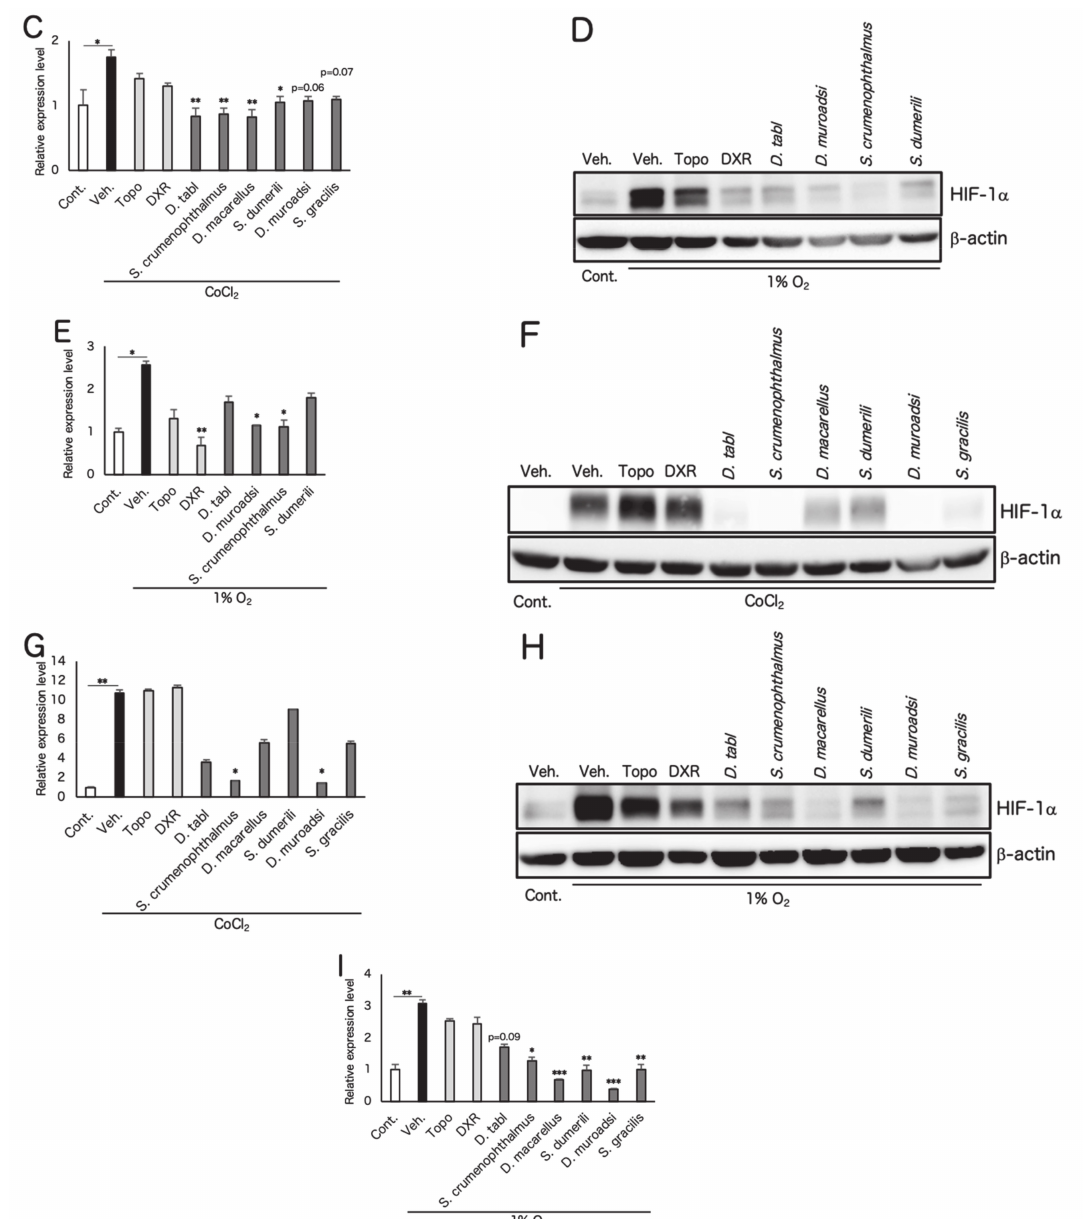
Figure 3. Fish ingredients suppress HIF-1a protein expression in vitro. Western blotting for HIF-1 α and HIF-2 α was performed under CoCl 2 condition in ARPE19 cells ( A ), and for HIF-1 α under 1% O 2 condition in ARPE19 cells ( D ), under CoCl2 ( F ) or 1% O2 conditions ( H ) in 661W cells. Quantification of the blots showed that the administration of fish ingredients suppressed increased HIF-1 α protein expression under CoCl 2 ( B ) or 1% O 2 conditions ( E ) in ARPE19 cells and under CoCl 2 ( G ) or 1% O 2 conditions (I) in 661W cells ( n = 3). Quantification of the blots also showed that the administration of fish ingredients suppressed the increased HIF-2 α protein expression under CoCl 2 in ARPE19 cells ( C ) ( n = 3). CoCl 2 was administered at a concentration of 200 mM, fish ingredients were added at 1 mg / mL simultaneously, and cells were incubated for 24 h. The hypoxic conditions were maintained for 48 h. Note that the fish ingredients inhibited HIF-1 α and HIF-2 α expression induced by CoCl 2 or hypoxia. * p < 0.05, ** p < 0.01, *** p < 0.001 compared with 1% O 2 / vehicle or CoCl 2 / vehicle. Error bars indicate mean plus SD. Veh., vehicle; Topo, topotecan; DXR,